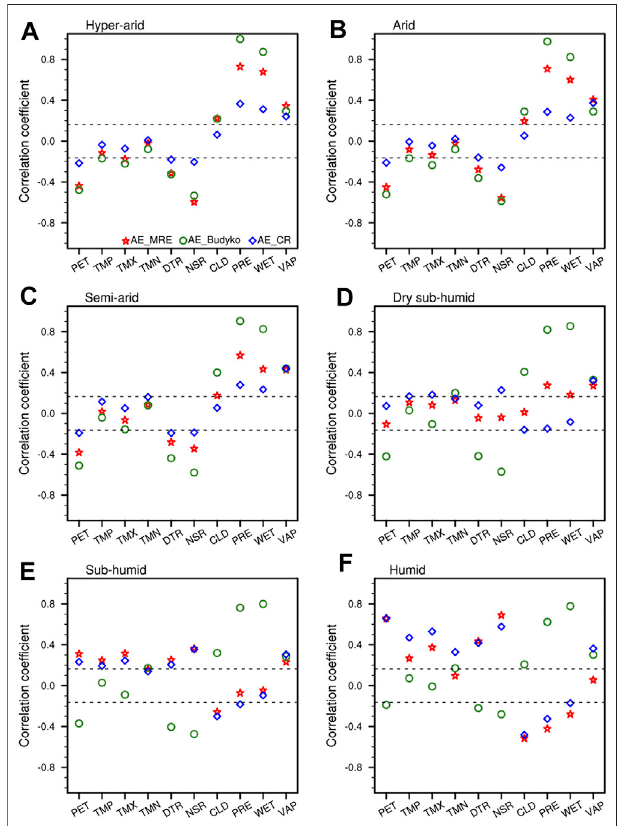
FIGURE 9 | Temporal correlation coef fi cients between X-12-ARIMA irregular component of actual evapotranspiration and in fl uencing factors over the (A) hyper-arid, (B) arid, (C) semi-arid, (D) dry sub-humid, (E) sub-humid, and (F) humid regions from 1982 to 2015. The local 99.9% con fi dence levels are about ± 0.164 based on Student ’ s t-